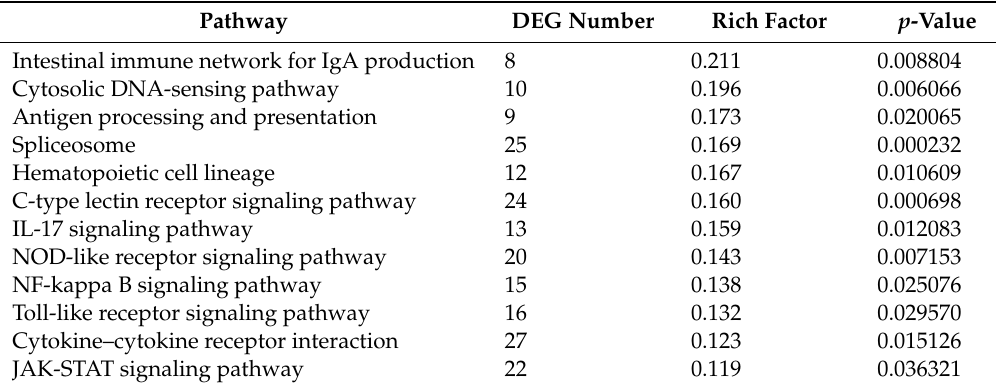
Table 2. Summary of the 12 significantly enriched KEGG pathways related to immunity. Pathway DEG Number Rich Factor p